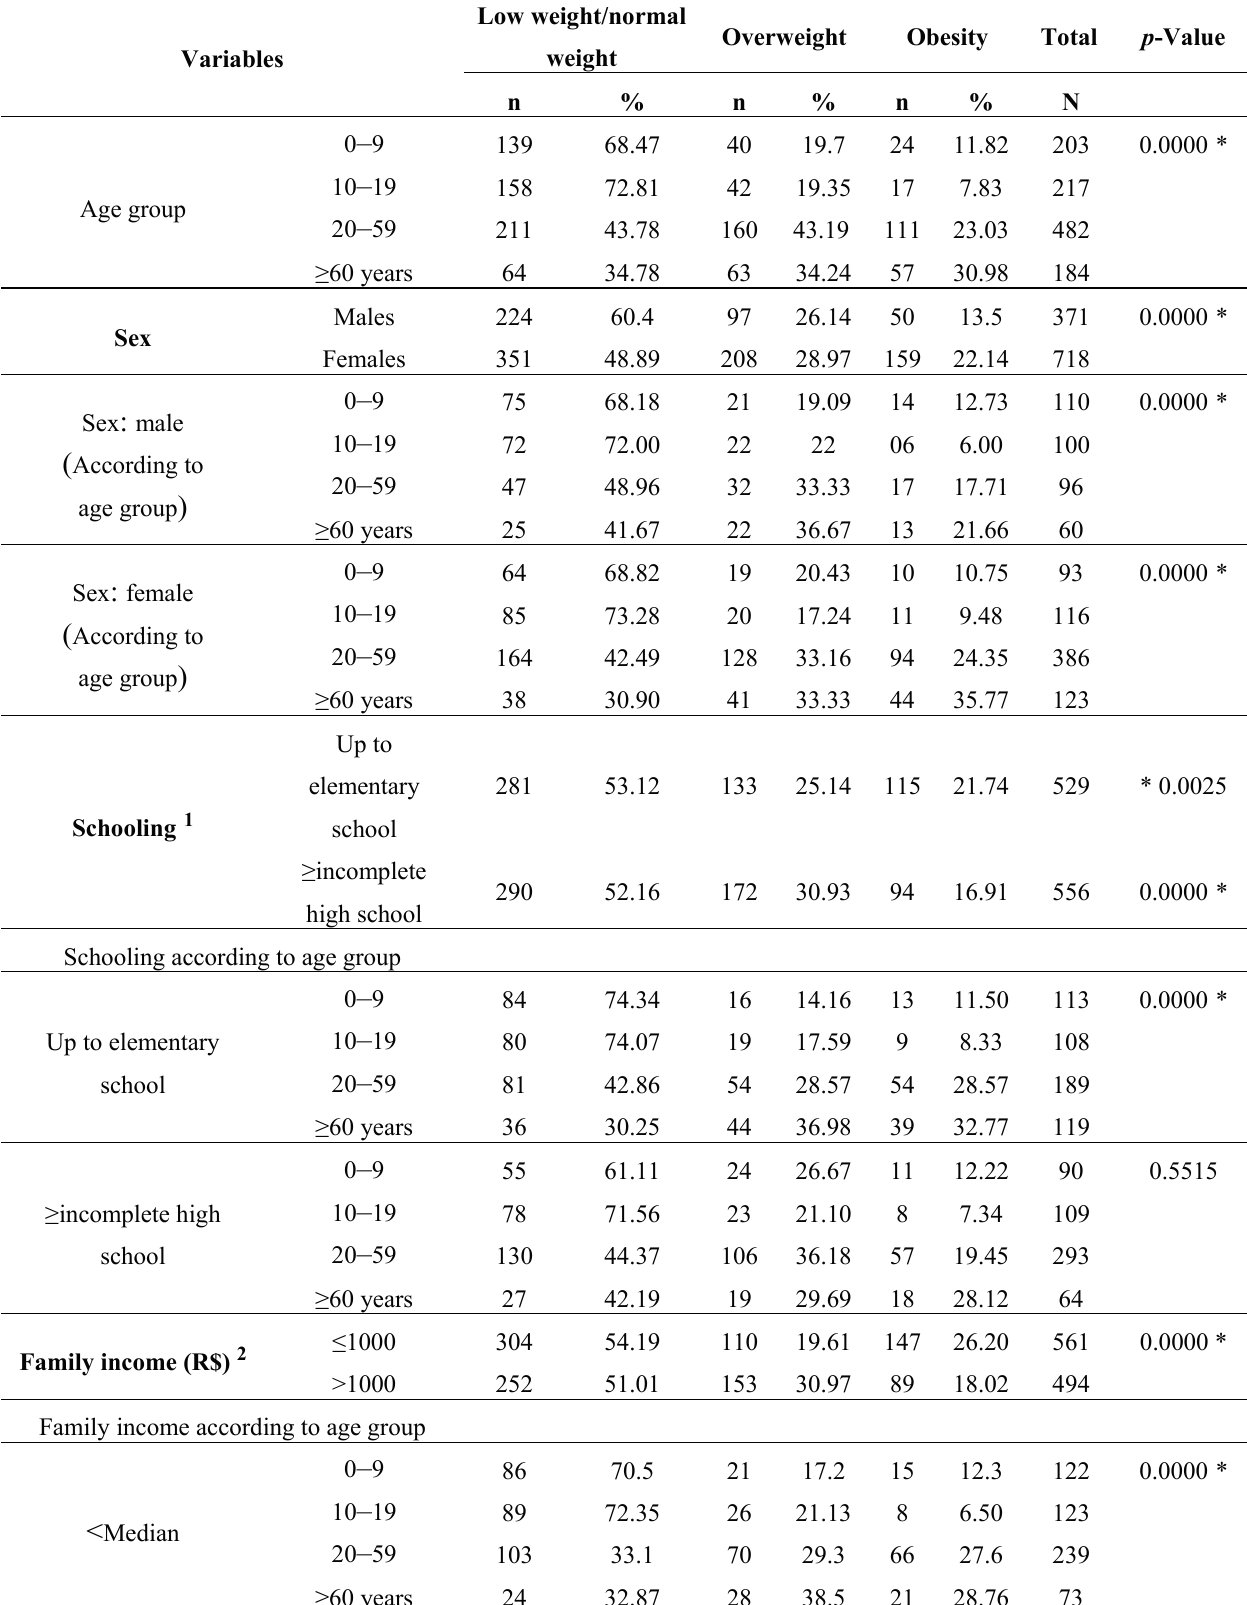
Table 2. Relationship between the nutritional status of individuals and socioeconomic, demographic and lifestyle indicators for all of individuals from I DISANDNT/JP, for the municipality of northeastern Brazil